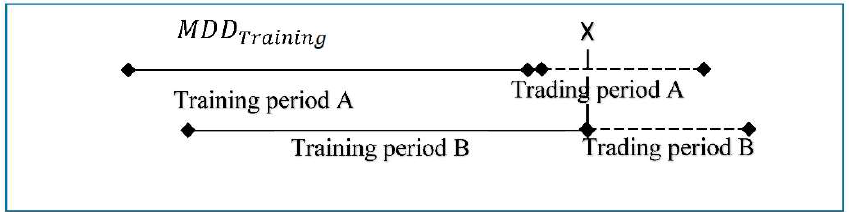
Figure 7. An illustration of how the risk management module of IDBA works. The symbol “x” denotes the time at which MDD Trading > MDD Training .